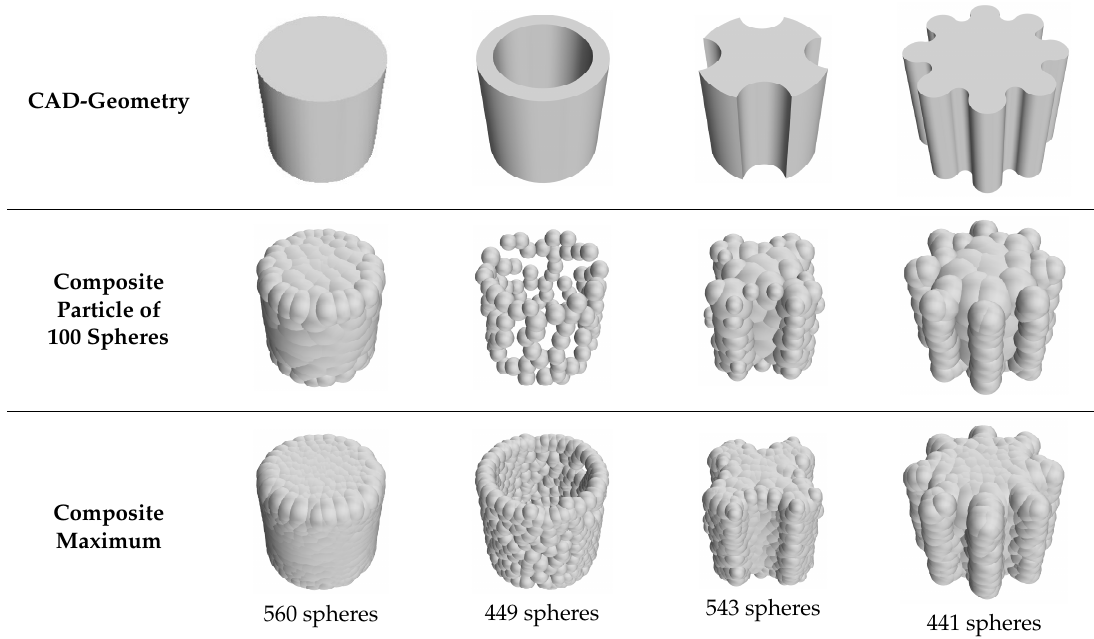
Table 1. Di ff erent particle geometries and composite particle approximation. Table 1. Different particle geometries and composite particle approximation. Table 1. Different particle geometries and composite particle approximation. Table 1. Different particle geometries and composite particle approximation. Table 1. Different particle geometries and composite particle approximation. Table 1. Different particle geometries and composite particle approximation. Table 1. Different particle geometries and composite particle approximation. Table 1. Different particle geometries and composite particle approximation. Table 1. Different particle geometries and composite particle approximation. Table 1. Different particle geometries and composite particle approximation. Table 1. Different particle geometries and composite particle approximation. Table 1. Different particle geometries and composite particle approximation. Table 1. Different particle geometries and composite particle